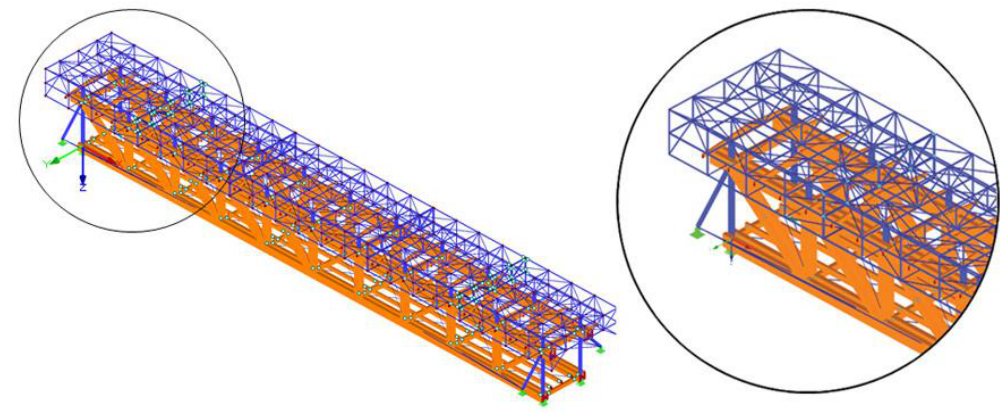
Figure 12. Three-dimensional model after the second update, with enlargement of the inserted cables.